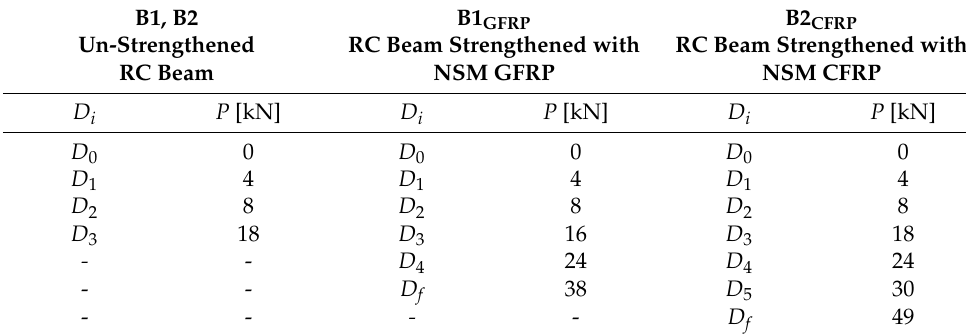
Table 2. Load cycles of each RC beam